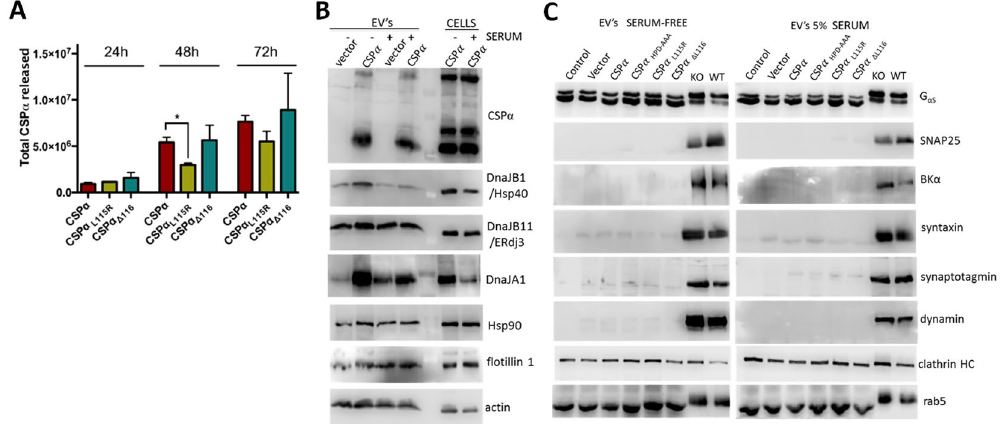
Figure 3. DnaJB11 and DnaJB1 are co-secreted with CSP α . ( A ) Quantification of the time course of WT and mutant CSP α release (media); ( * P < 0.05). ( B ) Immunoblot of EV’s released from vector or CSP α transfected cells probed with the indicated antibodies. 6 hrs after transfection the media was replaced with either serum free media or media containing 5% serum (exosome-free) and 48 hrs after transfection media was collected and exosomes prepared. Cell lysates are shown on the left hand lanes. ( C ) Immunoblot of EV’s isolated from control (untransfected), vector (3.75 μ g), myc-tagged CSP α (3.75 μ g), CSP α HPD-AAA (5 µ g), CSP α L115R (5 µ g), or CSP α L116 (5 µ g) transfected cells probed with the indicated antibodies. Crude synaptosomes from CSP α knock ∆ out and WT mice are shown in the right lanes. Western blots are representative of 5 independent